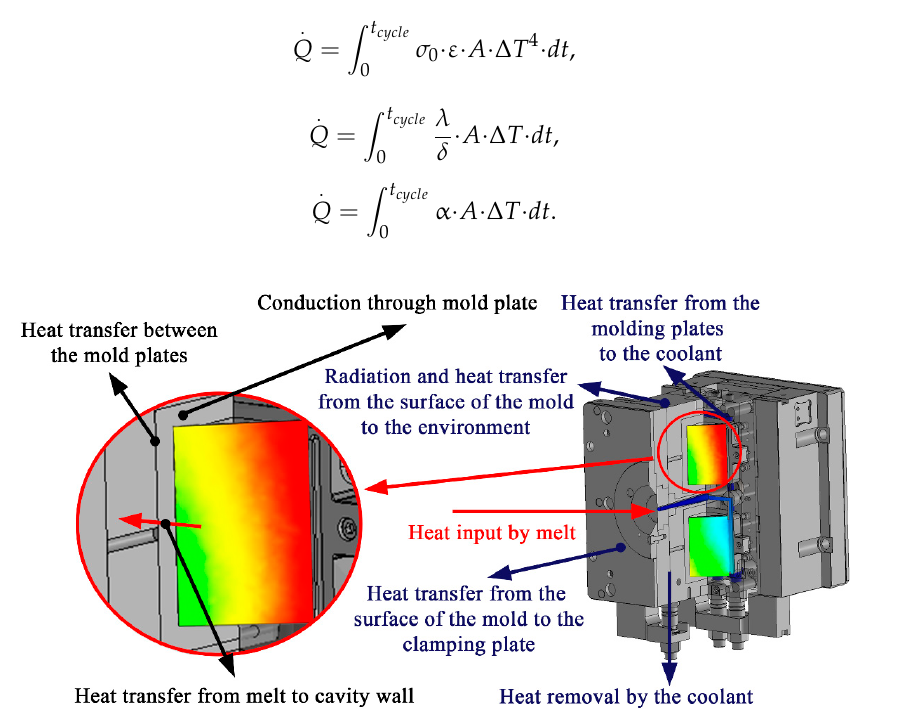
Figure 1 . Heat transfer in the mold. Figure 1. Heat transfer in the